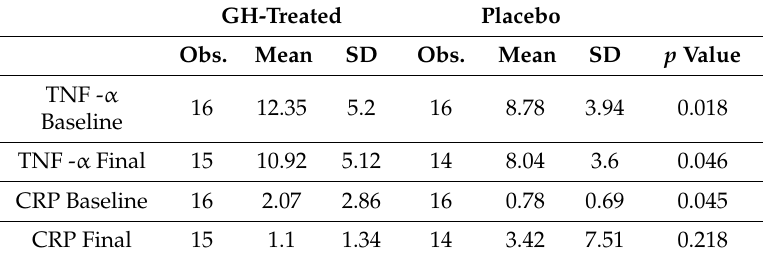
GH-Treated Placebo Obs. Mean SD